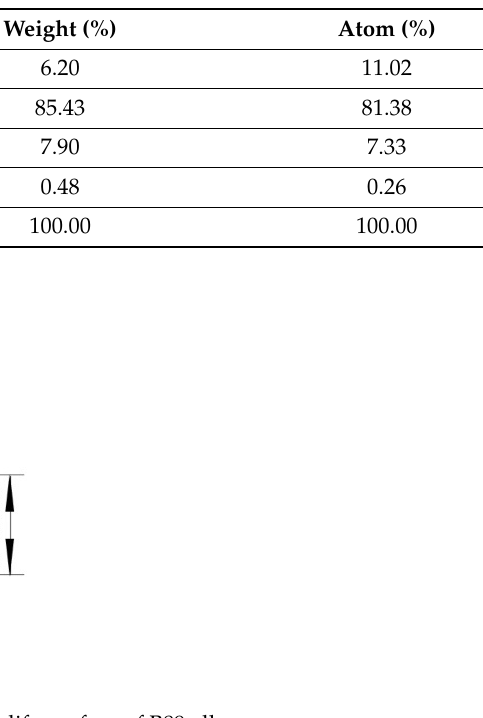
values and standard deviations were determined. Flexural strength tests were conducted